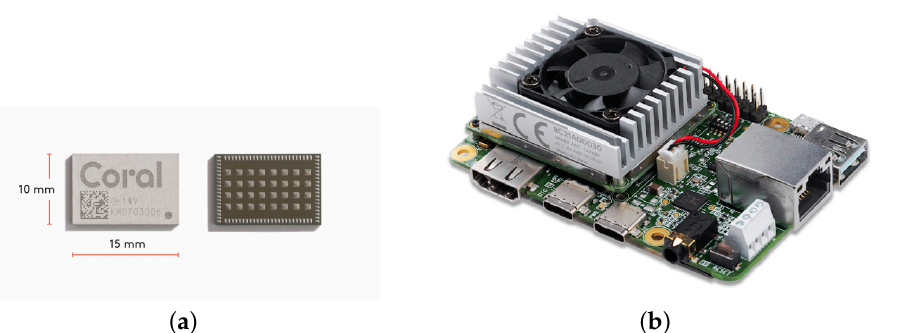
Figure 2. ( a ) EdgeTPU AI accelerator module; ( b ) Coral Deep Learning embedded hardware with EdgeTPU AI accelerator module. Images from https://coral.ai/products/dev-board/ (accessed on 2 September